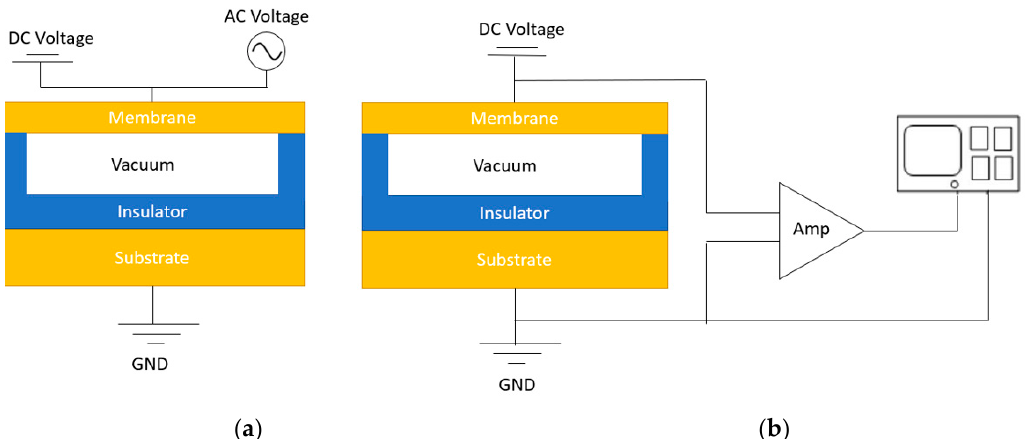
Figure 2. ( a ) Capacitive micromachined ultrasound transducers (CMUT) transmission mode; ( b ) CMUT receiving